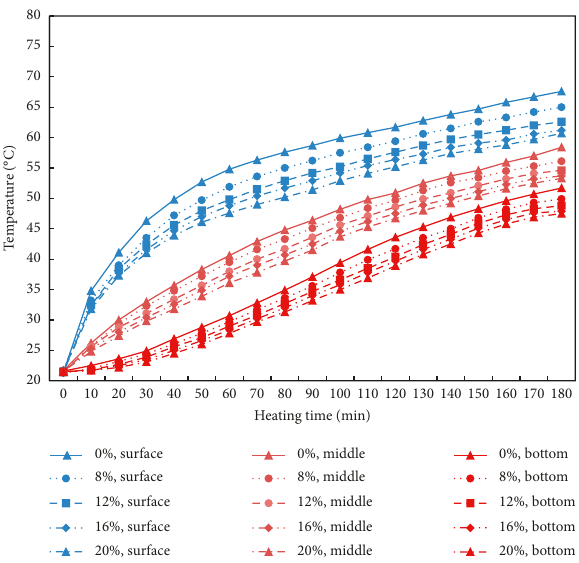
Figure 14: Temperature difference results of tests on the APC-AC indoor rutting slabs.